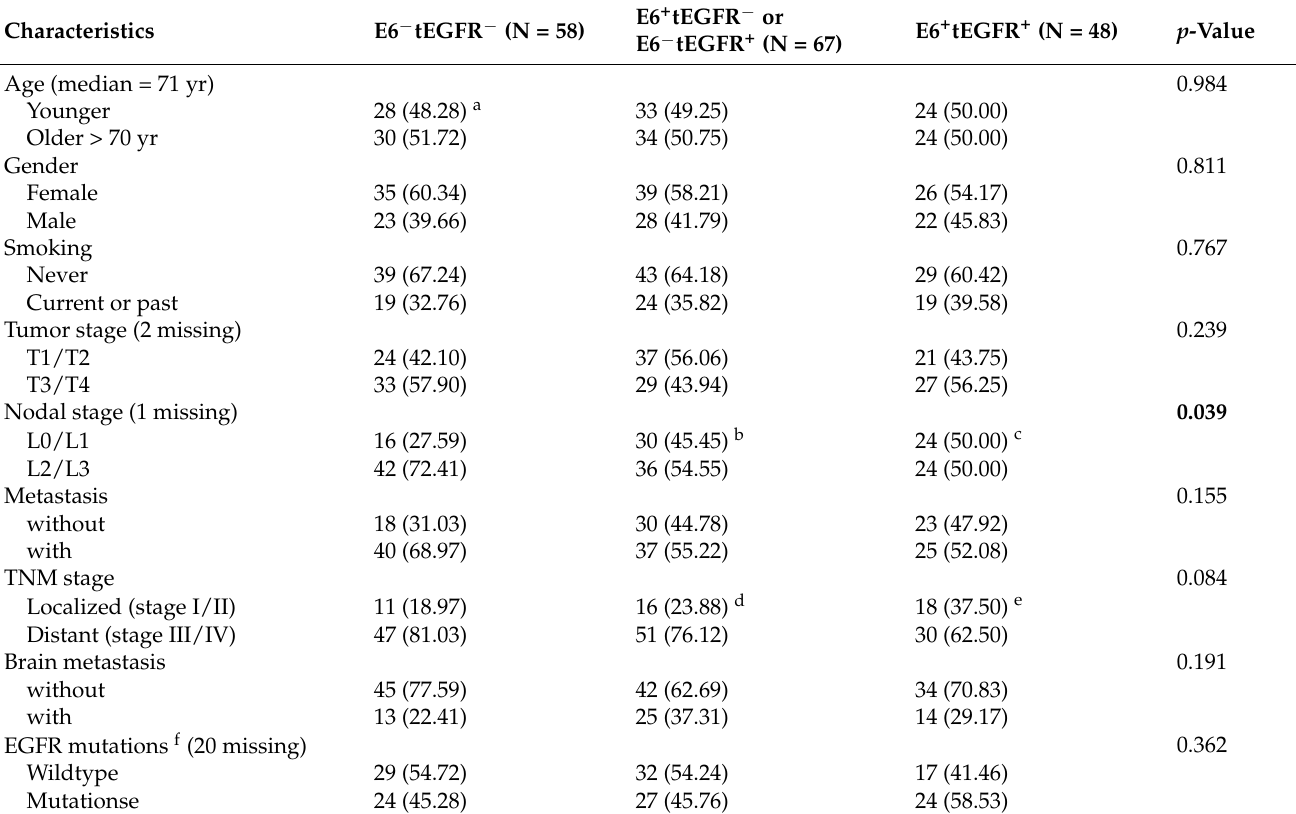
Table 2. Distribution of HPV 16E6/18E6 expression related to total EGFR expression in 173 lung adenocarcinoma